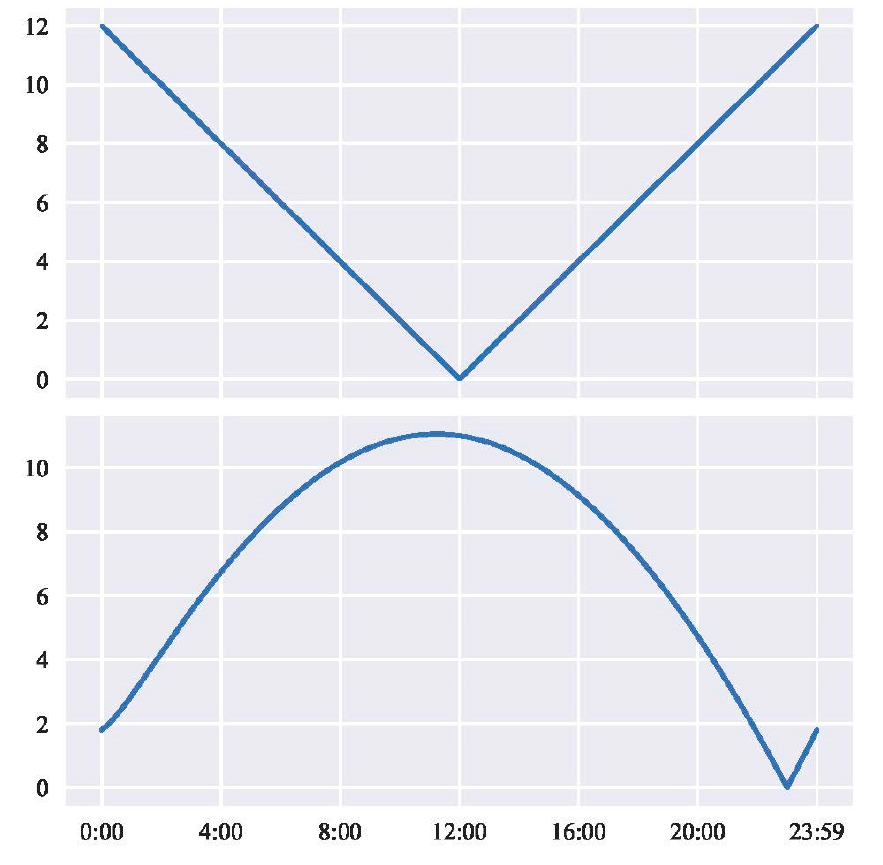
Figure 2. Considerations for the time component. Top panel presents temporal distance from 12 h (midday), and the bottom panel presents distance from midnight.